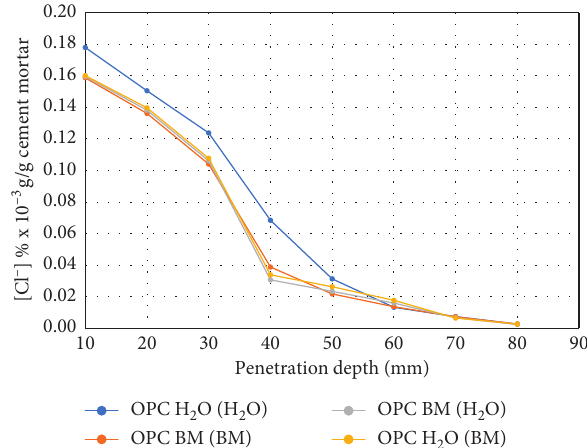
Figure 8: Chloride ion concentration at different depth of pene- tration for control OPC and varied Bacillus megaterium microbial